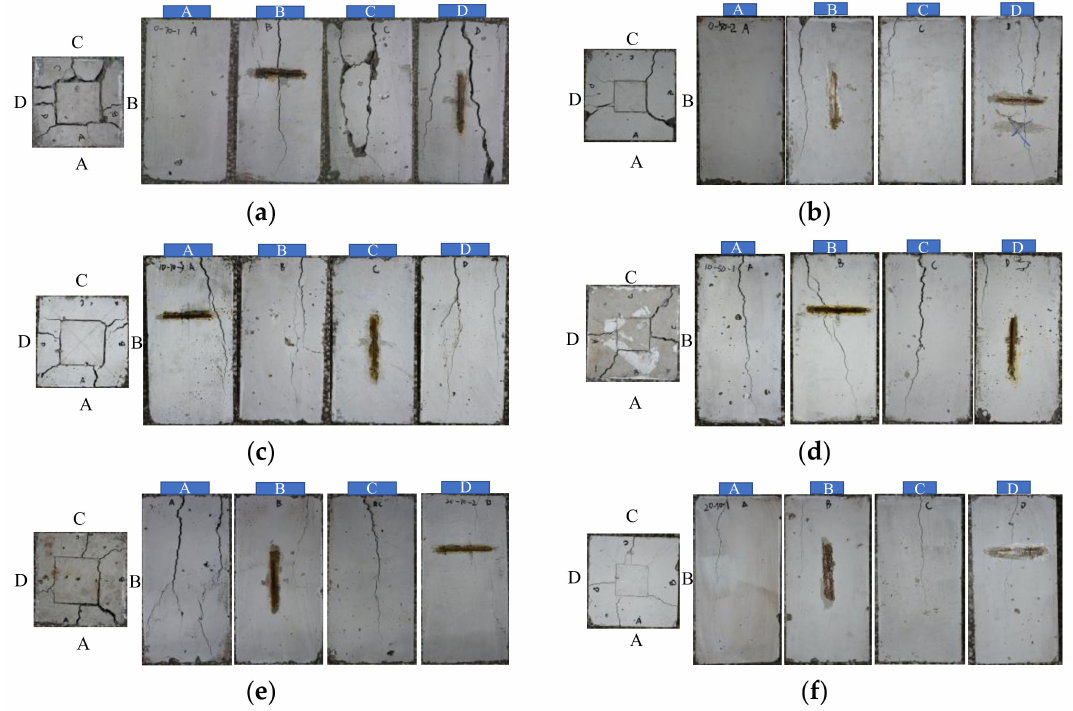
Figure 9. Failure modes: ( a ) NC-75-1; ( b ) NC-50-2; ( c ) CRC5-75-3; ( d ) CRC5-50-1; ( e ) CRC10-75-2; ( f )